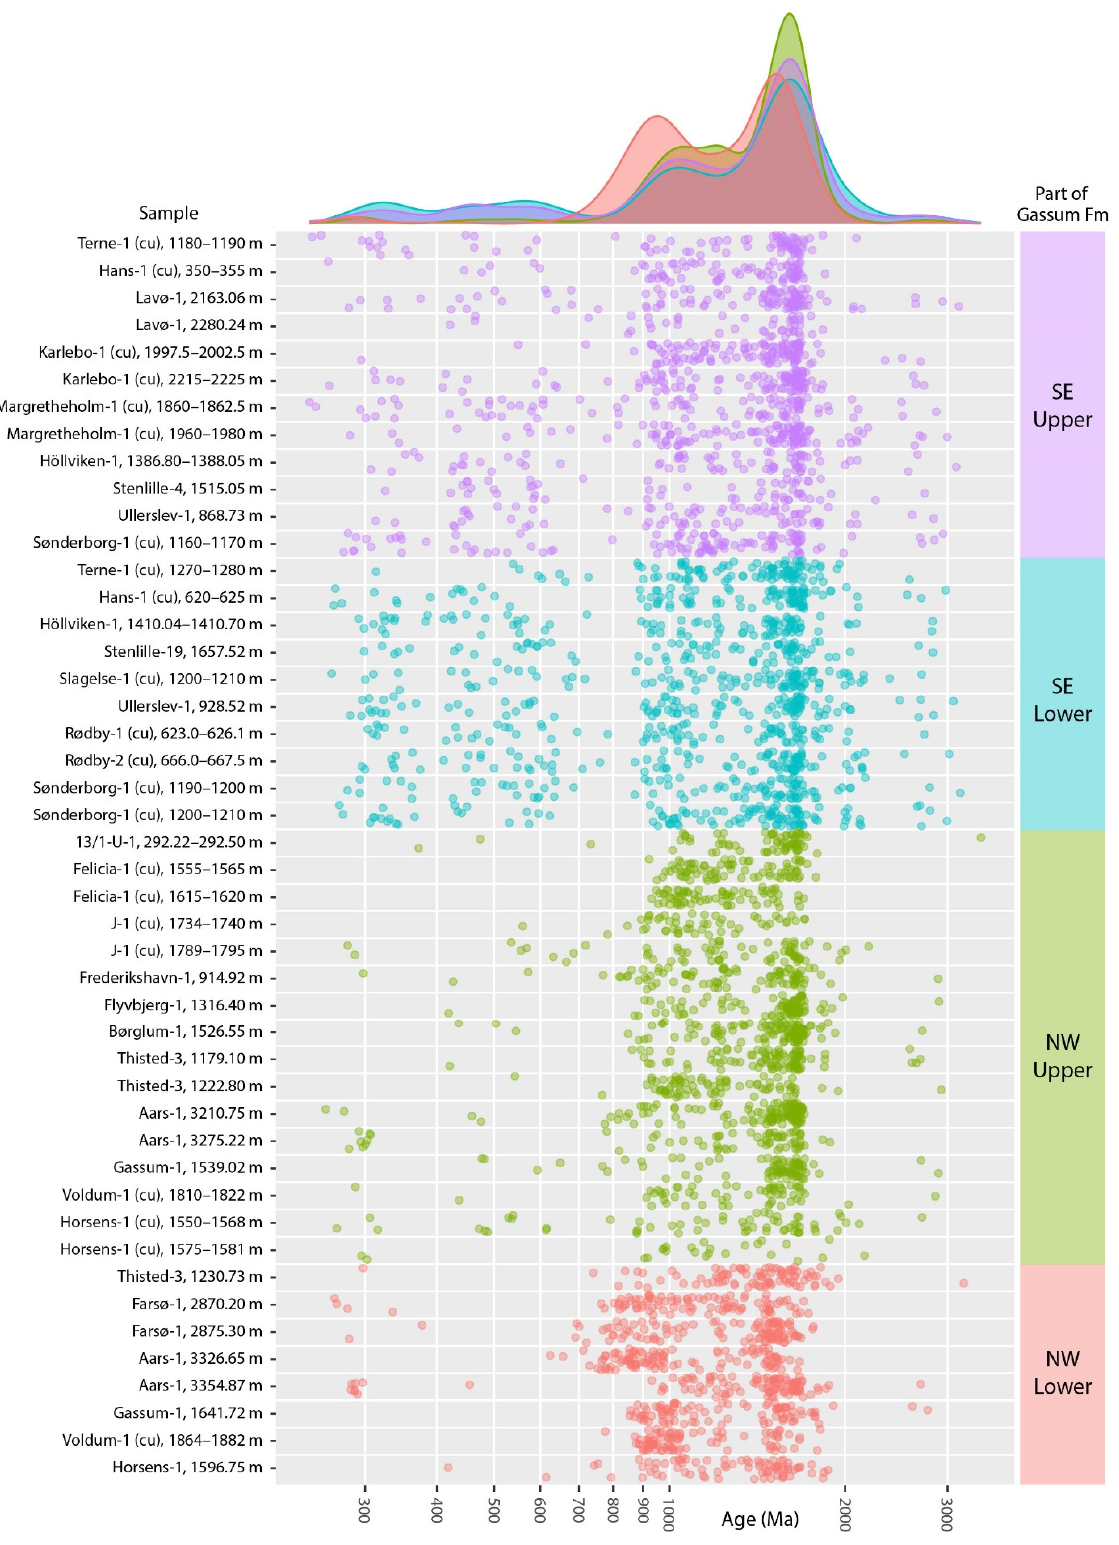
Figure 9. Plot of 206 Pb/ 238 Pb and 207 Pb/ 206 Pb zircon data with crossover at 1200 Ma plotted for all samples on a logarithmic scale. The samples are grouped into the NW and SE part of Gassum For- mation, and into the lower and upper part (divided by sequence boundary 5). The probability den- sity distributions at the top show the merged age distribution for each of these groups. Most samples are from cores, and some are from cuttings (cu).